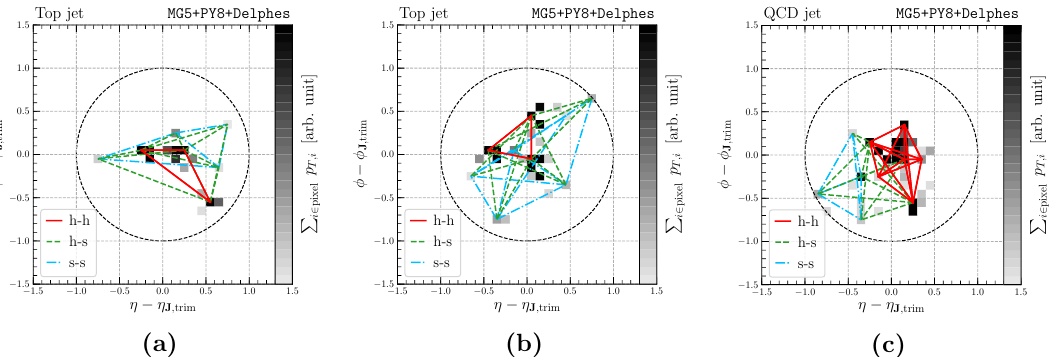
Figure 2. Schematic diagrams of the graph representations of jets. (a) and (b) are top jet images, and (c) is a QCD jet image. Lines represent the graphs on the jet images. The red solid lines are edges between the constituents of the trimmed jet J trim . The green dashed lines are the edges between the constituents of J trim and the constituents of J n J trim . The blue dot-dashed lines are edges between the constituents of J n J trim . Note that we omitted some edges for